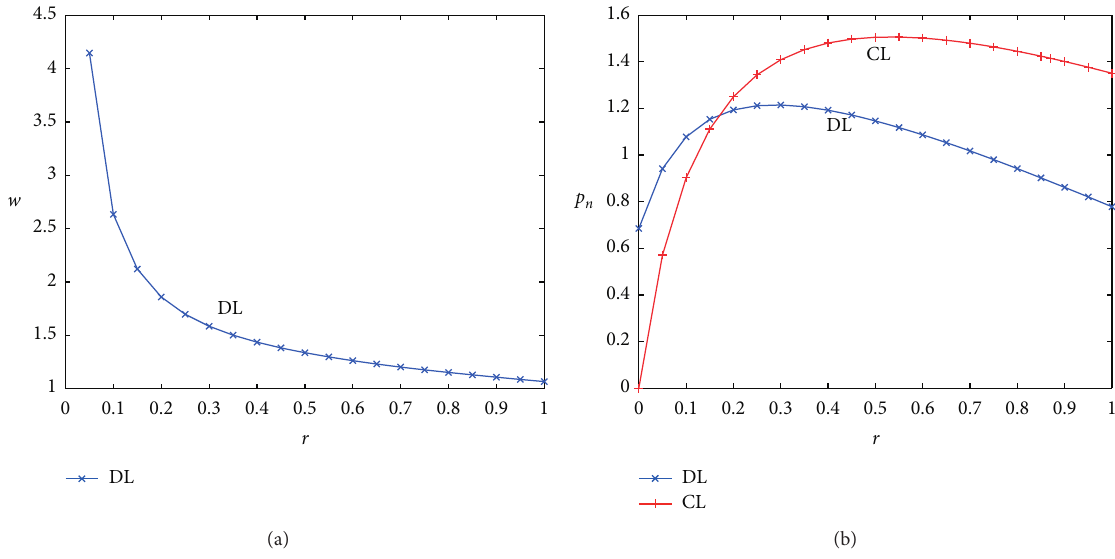
Figure 3: The impact of consumer heterogeneity on wholesale price and retail price: (a) wholesale price and (b) retail price.